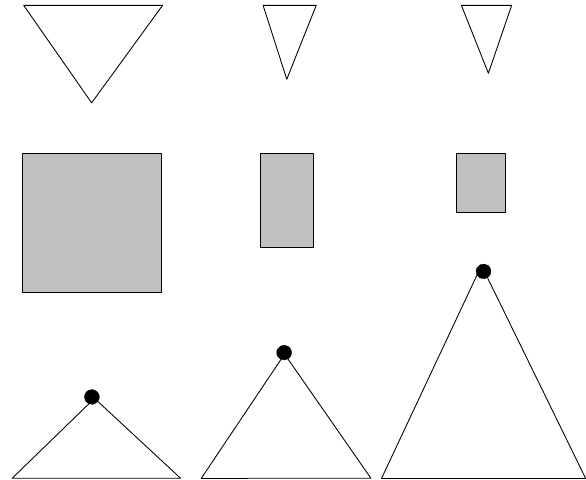
Figure 1. Characteristics of aerial cameras of Intergraph. The symbols mean: From left to right: Film-based wide angle cam- era, digital cameras DMC and DMCII-250. From top to bottom: FOV in the direction of flight, format, flying height for the same GSD, and FOV across the direction of